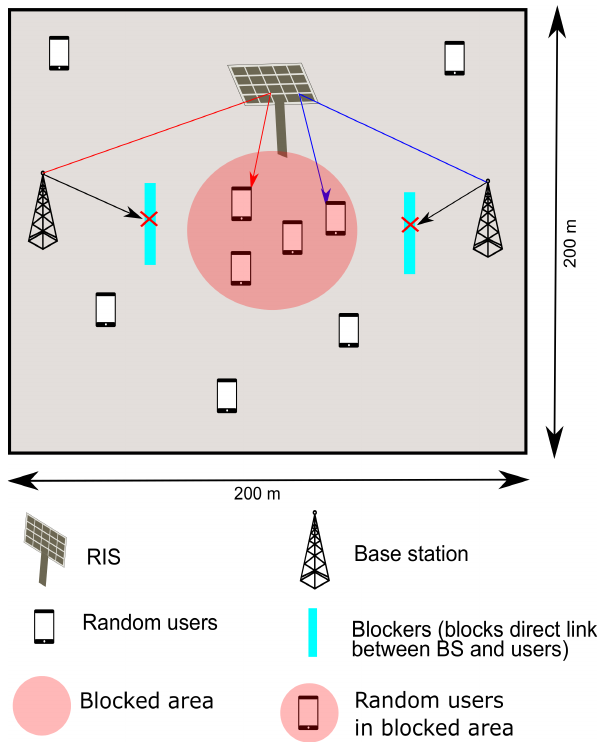
Figure 4. RIS sharing simulation